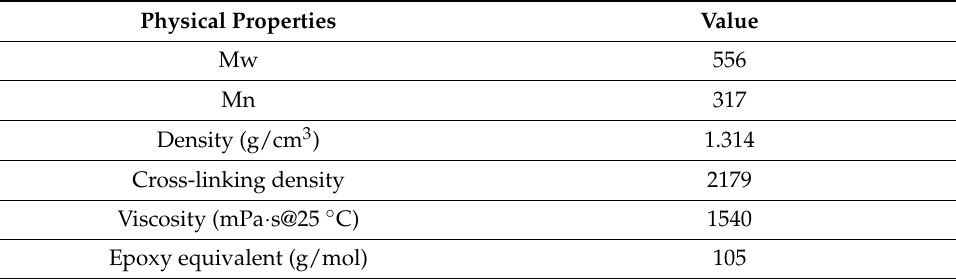
Table 1. Basic properties of AFG-90H